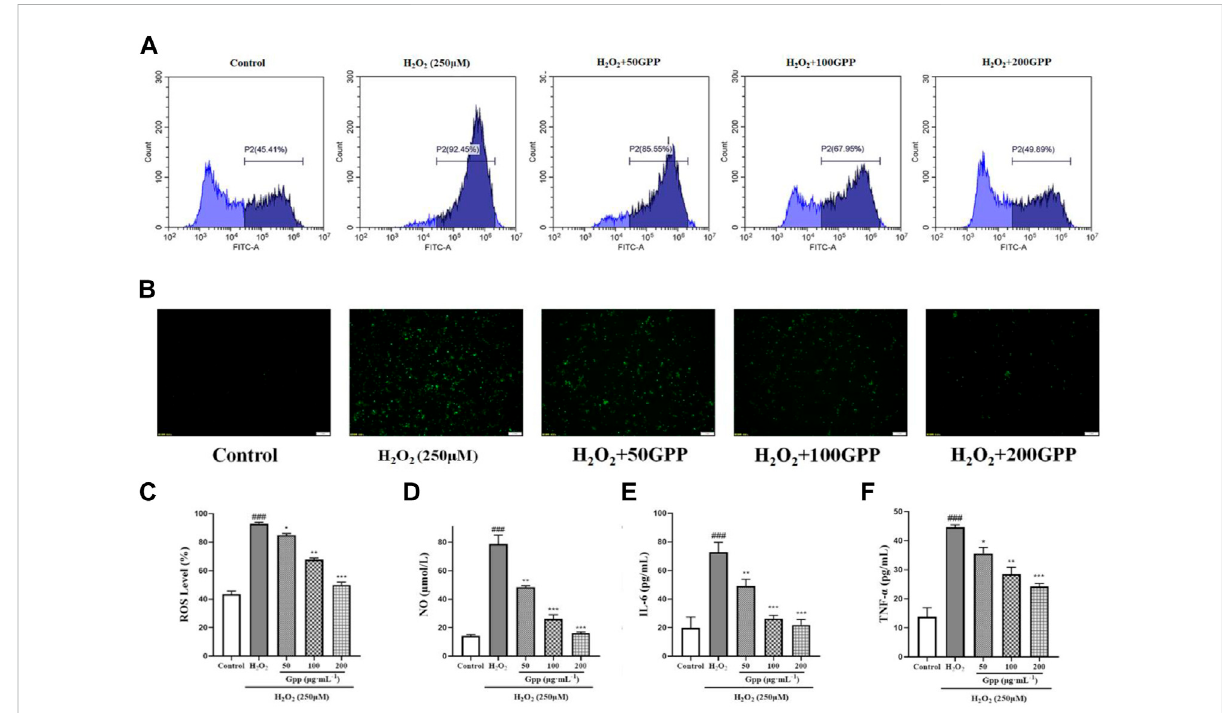
Effect of GPP pretreatment on ROS and neuroin fl ammation in injury models. Where (A) is the fl uorescence intensity of ROS probe detected using fl ow cytometry, (B) is the fl uorescence intensity of cellular ROS detected using fl uorescence inverted microscopy, and (C) Statistical results